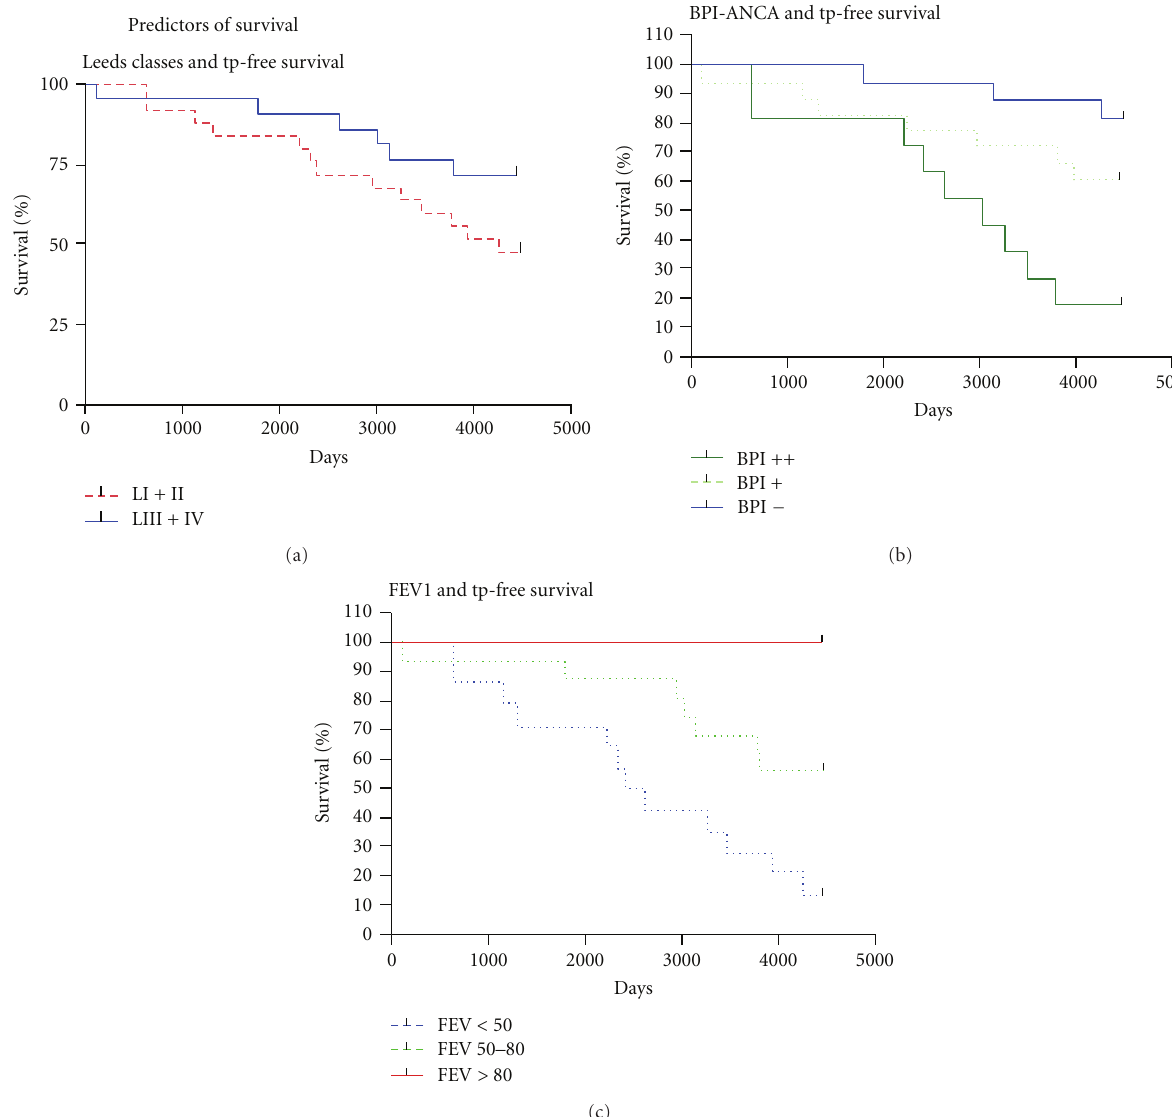
Figure 1: (a) PsA colonization and transplantation free survival. The blue line shows patients who are not chronically colonized with PsA (never had PsA or free from earlier colonization, Leeds class IV or III). The red line shows patients who are chronically or intermittently colonized with PsA (Leeds class I or II) (log rank test P = 0 . 13). (b) BPI-ANCA and days of transplantation free survival. The blue line indicates patients without IgA-BPI-ANCA, the dotted line patients with IgA-BPI-ANCA level of 67–200, and the green line patients with a BPI-ANCA above 200 at inclusion. There is a clear di ff erence in transplantation free survival for BPI-negative patients compared to patients with a high BPI-ANCA (log rank test P = 0 . 002). (c) Lung function and transplantation free survival. Patients with FEV1 > 80% pred, FEV1 between 50 and 80% pred, and FEV1 below 50% pred are indicated by red line, green dotted line, and blue dotted, respectively. None of the patients with a normal lung function at inclusion die or receive a lung transplant during over ten years of followup. The patients who have a low lung function at the start of the study experience a negative outcome to a very high degree (log rank test P < 0 . 001).